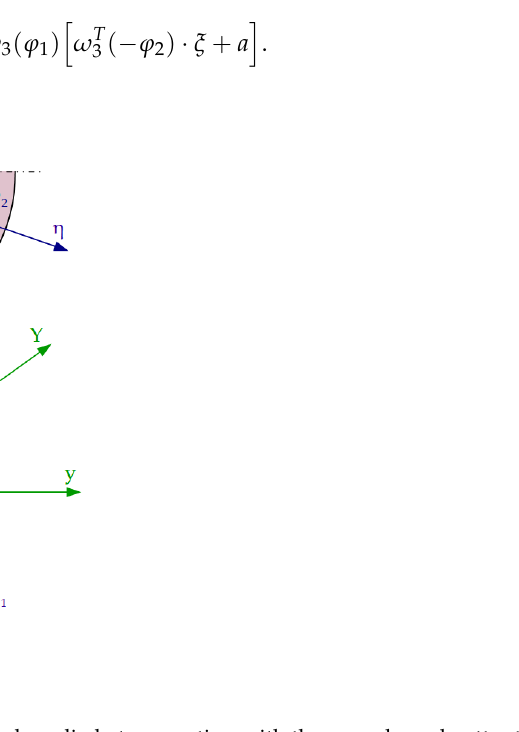
Figure 10. The minimum distance method applied at generating with the gear shaped cutter tool [2].